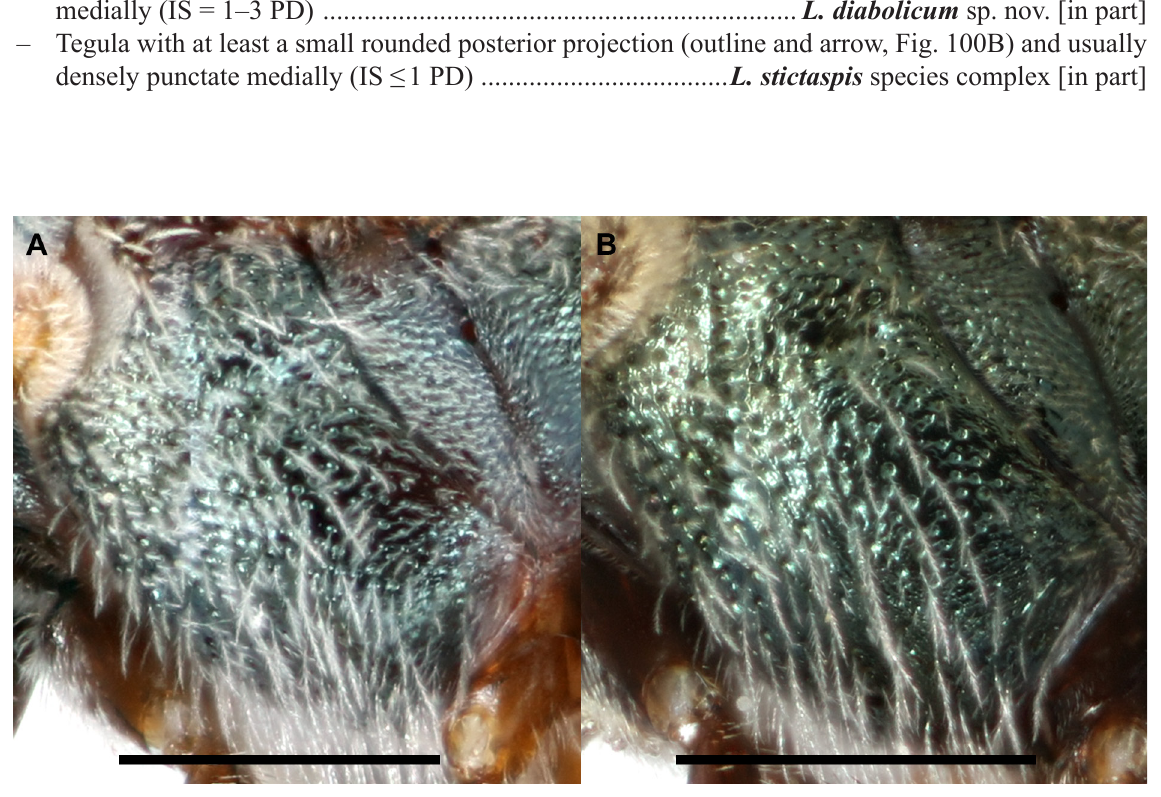
Fig. 99. Mesepisternum. A . Lasioglossum ellisiae (Sandhouse, 1924), ♀, punctures similar to hypoepimeron. B . L. diabolicum sp. nov., ♀, punctures slightly larger and coarser than on hypoepimeron. Scale bars = 0.5